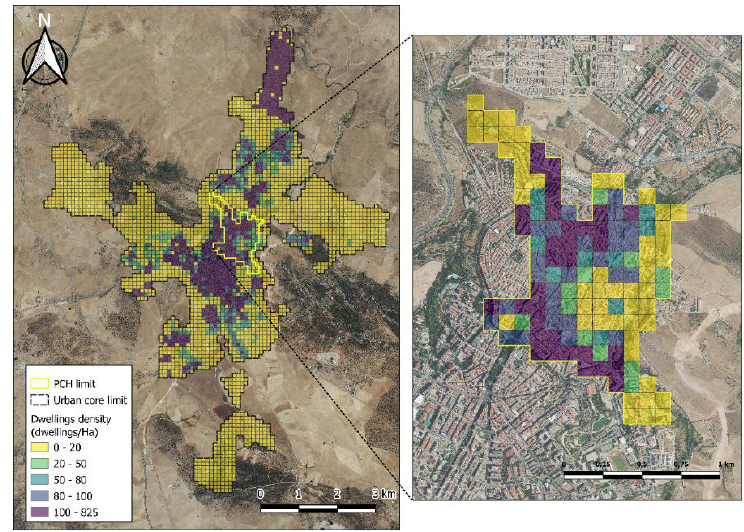
Figure 3. Dwelling density comparison.